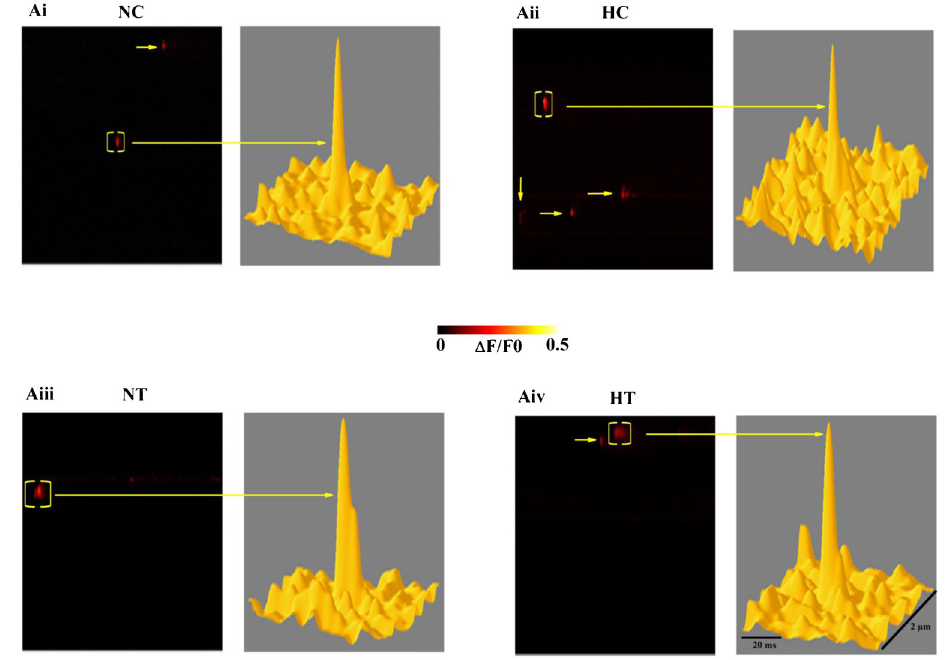
Figure 2. Representative images (Ai to Aiv) of spontaneous Ca 2++ sparks recorded from left ventricular isolated cardiomyocytes. NC: normotensive control; HC: hypertensive control; NT: normotensive trained; HT: hypertensive trained.